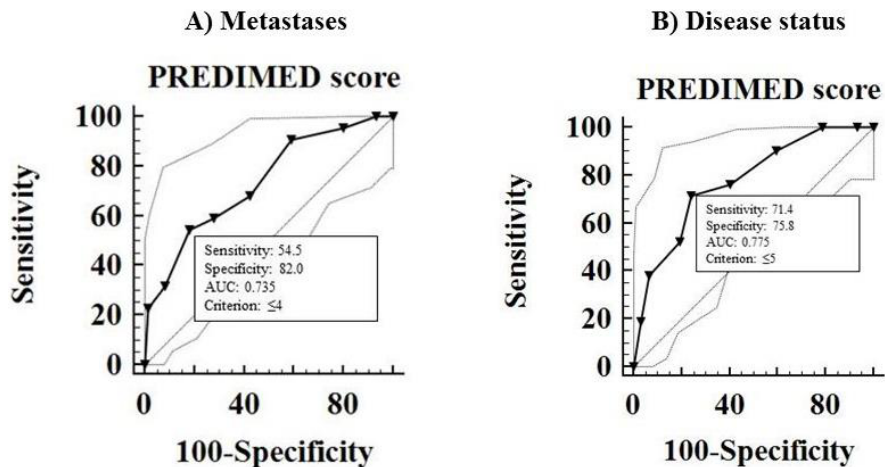
Figure 4. ROC analysis to determine the cut off values of the PREDIMED score for the evaluation of increased risk of metastases ( A ) and progressive disease ( B ). Abbreviation: PREDIMED, PREvención con DIeta MEDiterránea; PhA, phase angle; ROC, Receiver operator